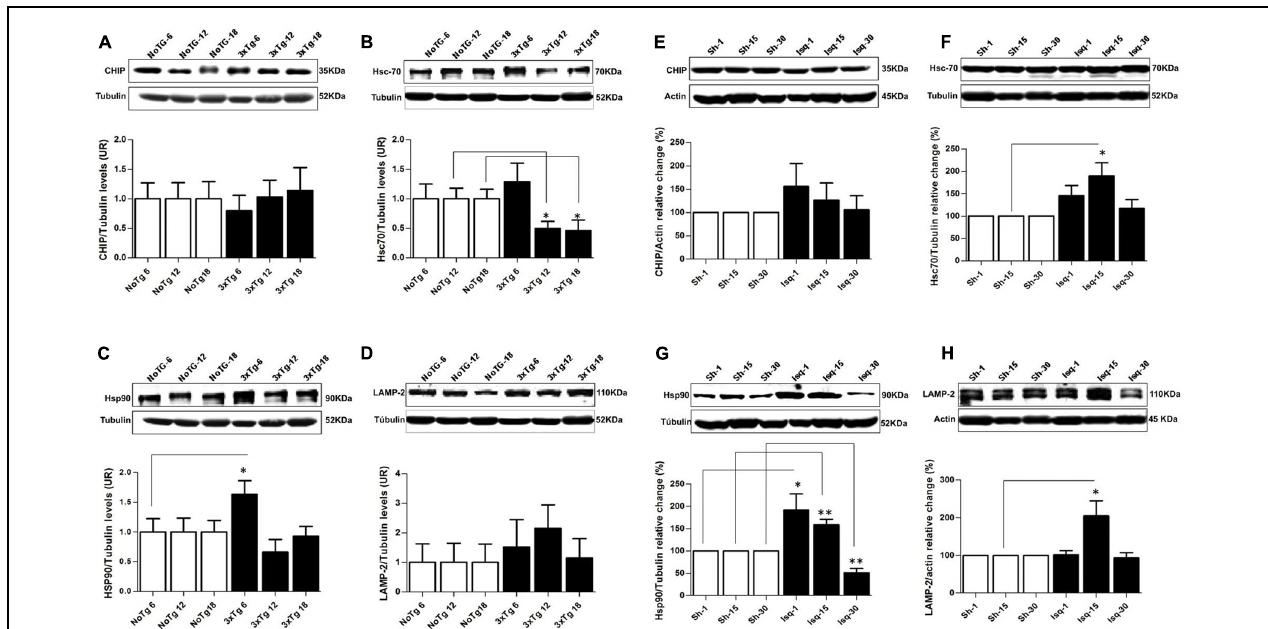
(G) Hsp90 levels increased at 1 ( p ≤ 0.0432) and 15 days ( p ≤ 0.0093) and decreased at 30 days ( p ≤ 0.0076) after ischemia. The data were normalized against the internal control for each time point in the NoTg mice and sham rats, respectively. β -III tubulin and actin were used as the loading controls. The data are shown in the bar graph as AUs. The data were compared to the internal control values for each time point in the disease progression. The data are presented as the mean ± SEM; n = 3–5; ∗ p < 0.05; ∗∗ p <